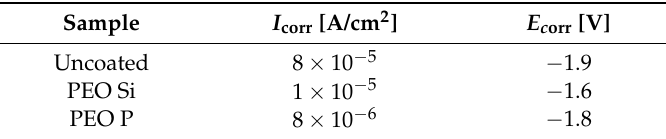
Table 3. Corrosion potentials and corrosion current density extrapolated from the potentiodynamic polarization plot.